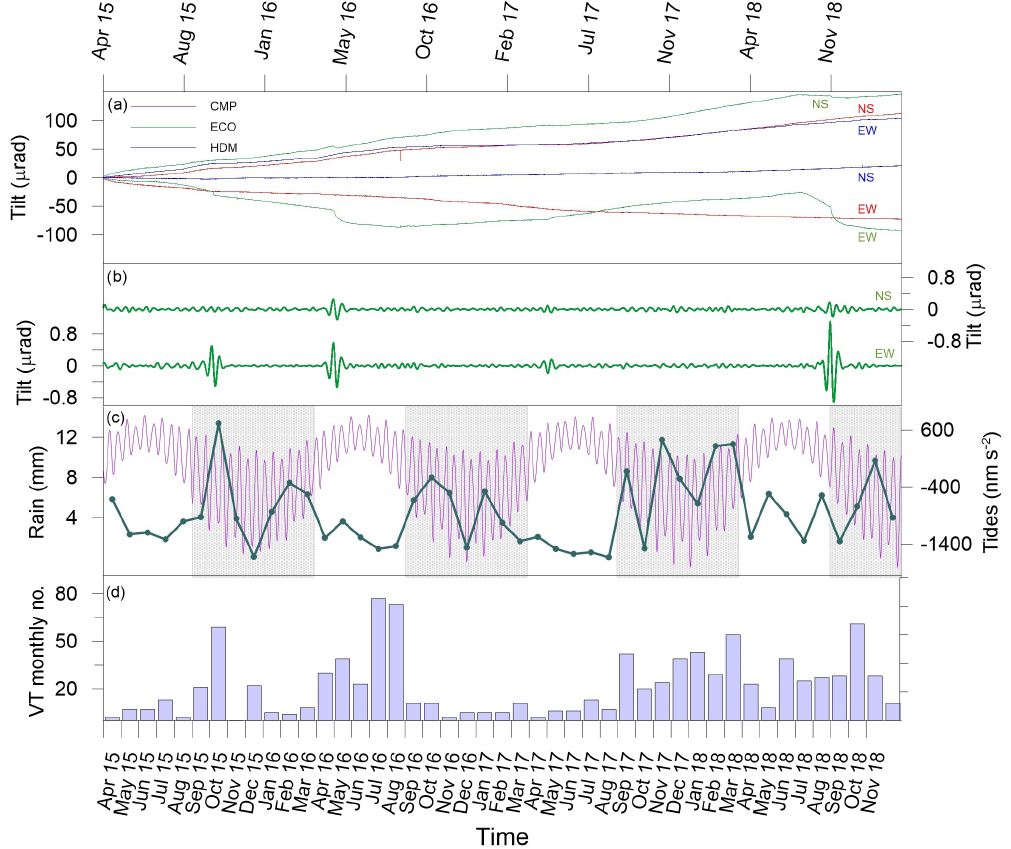
Figure 6. (a) Tilt time series from 1 April 2015 to 31 December 2018; (b) ECO tilt time series filtered in the period band corresponding to the Mf constituent; (c) solid Earth tides (magenta line) and rainfall time series (dark green line). The light-grey boxes in the background mark the wet season of the hydrological year; (d) monthly number of VTs (redrawn after Ricco et al.,